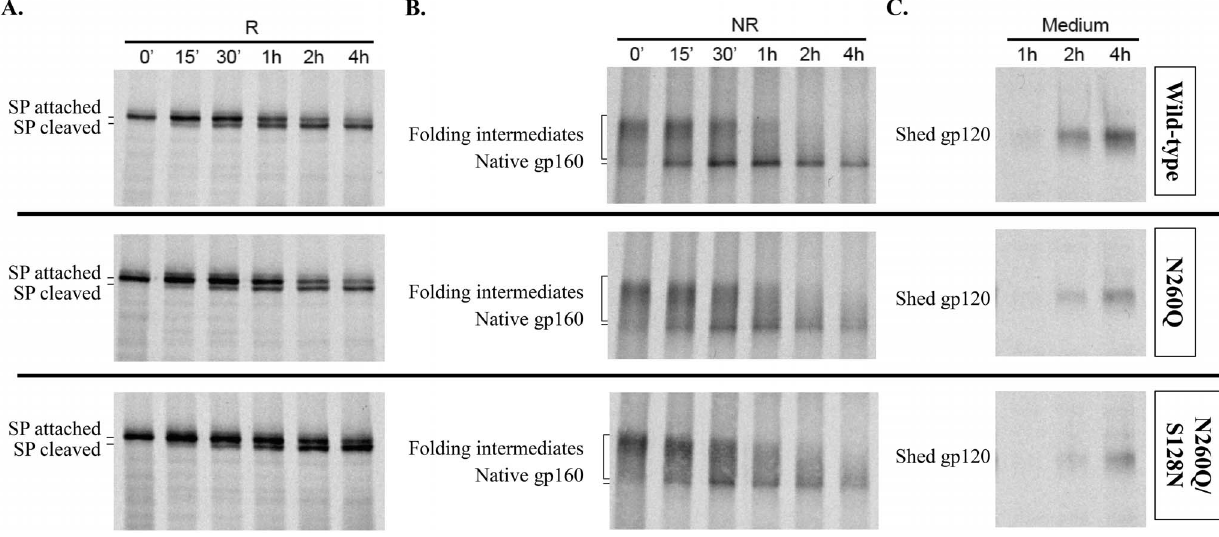
Figure 6. Pulse-chase experiments to study signal peptide cleavage, oxidative folding and gp120 shedding. HeLa cells transfected with WT or mutant gp160 were pulsed with Express 35 S protein labelling mix during 10 min and chased with cold cysteine and methionine for the indicated time. Films in panel A were exposed for 7 days and in panel B and C for 14 days. (A) Reducing (R) SDS-PAGE to study signal peptide cleavage. (B) Non-reducing (NR) SDS-PAGE to study oxidative folding. (C) Detection of shed gp120 in culture medium. SP: signal peptide.